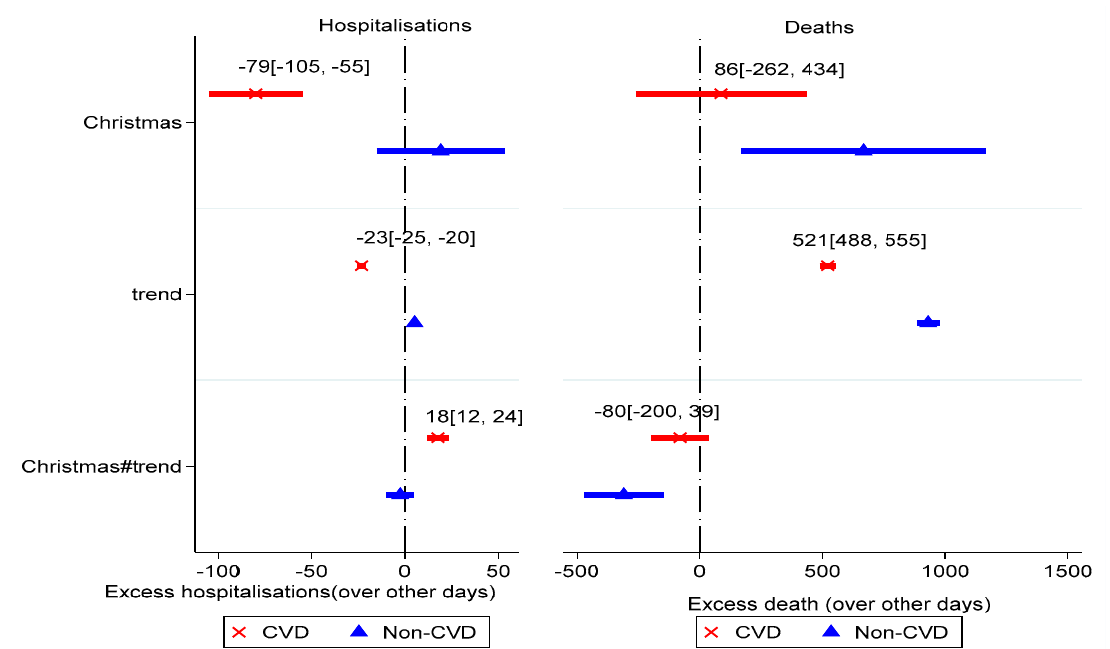
Figure A1. Sensitivity results for trends in December holidays CVD events.